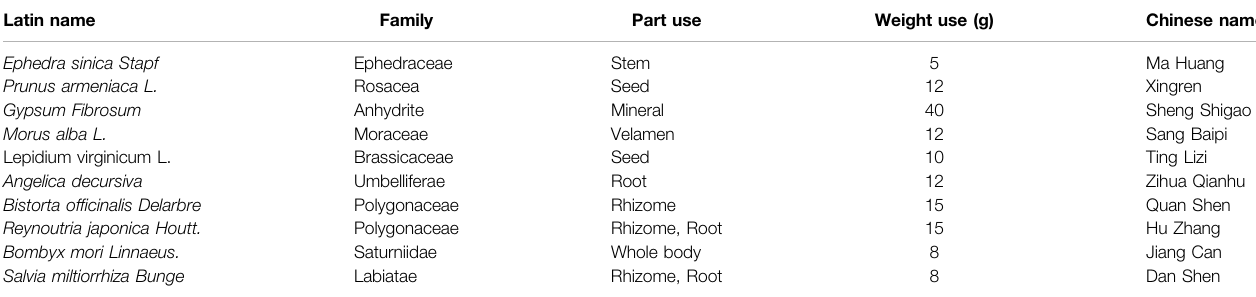
TABLE 1 | Composition of QF.